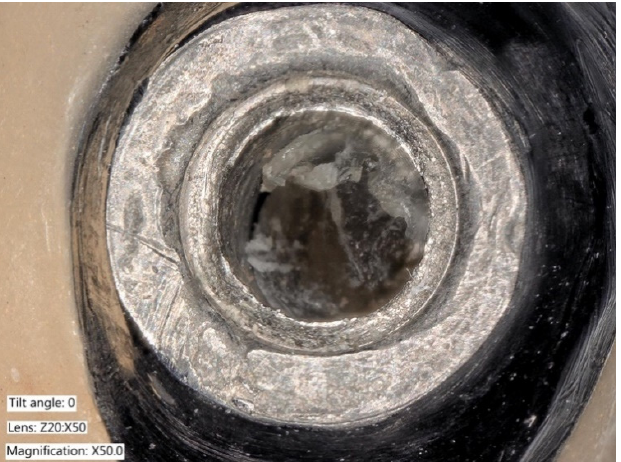
Figure 13. Evaluation of the basal aspect of the implant crown, showing deformation of the hexagon, and particle delamination.